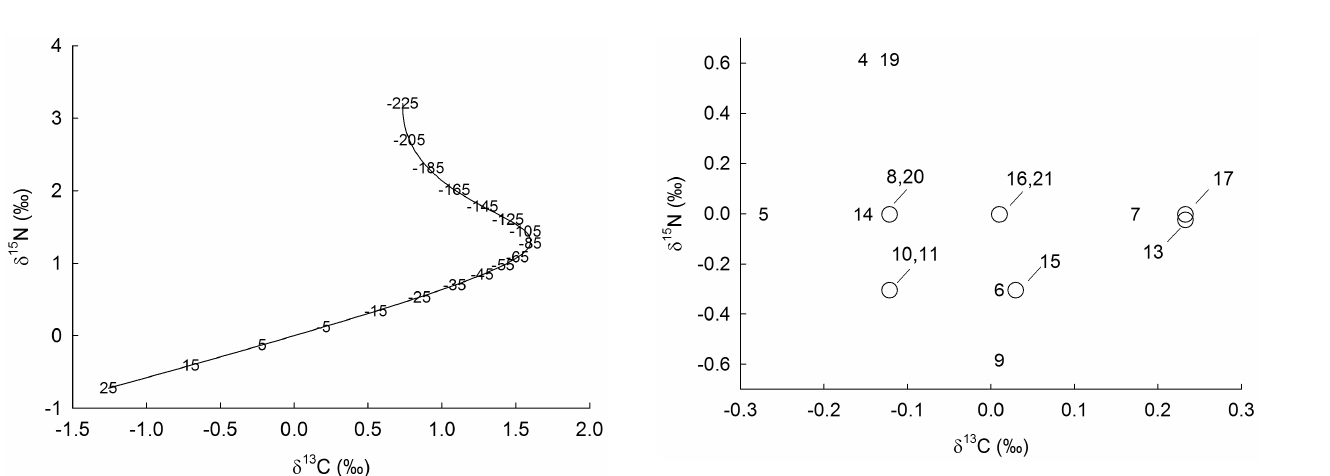
Figure 4. Depth coefficients of δ 15 N and δ 13 C calculated from the three depth terms in the regression models. The depth in centimeters for specific points is indicated on the line.